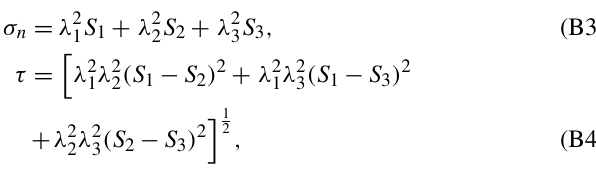
lower (cid:49)P for shear slip as the causative plane of a particular event. Clearly, lower (cid:49)P results in lower CPP. Those faults are closer to the failure condition for shear